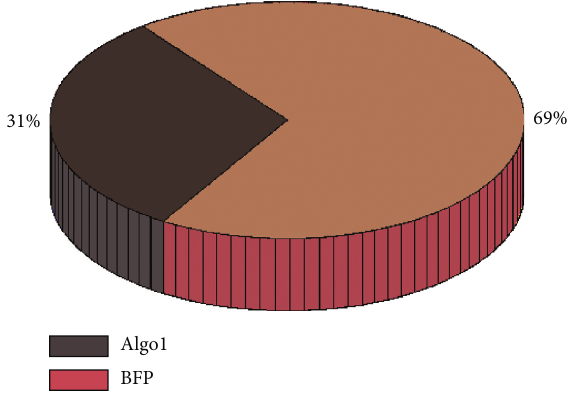
Figure 3: Pie chart for average CPU time.